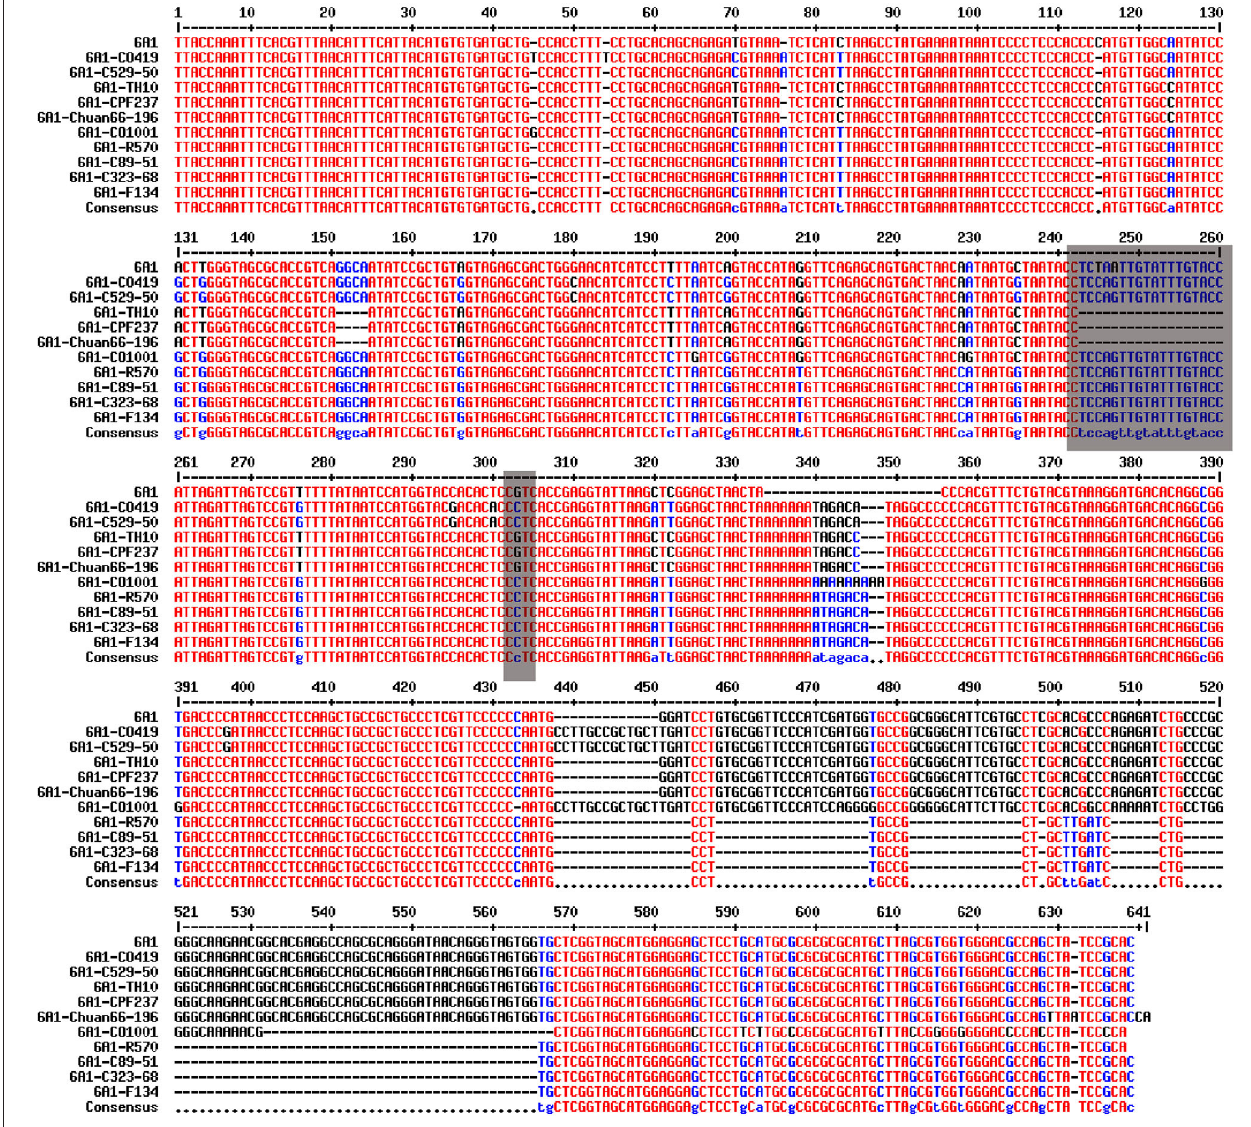
of 5 × using an Illumina Hiseq 2500. The raw reads